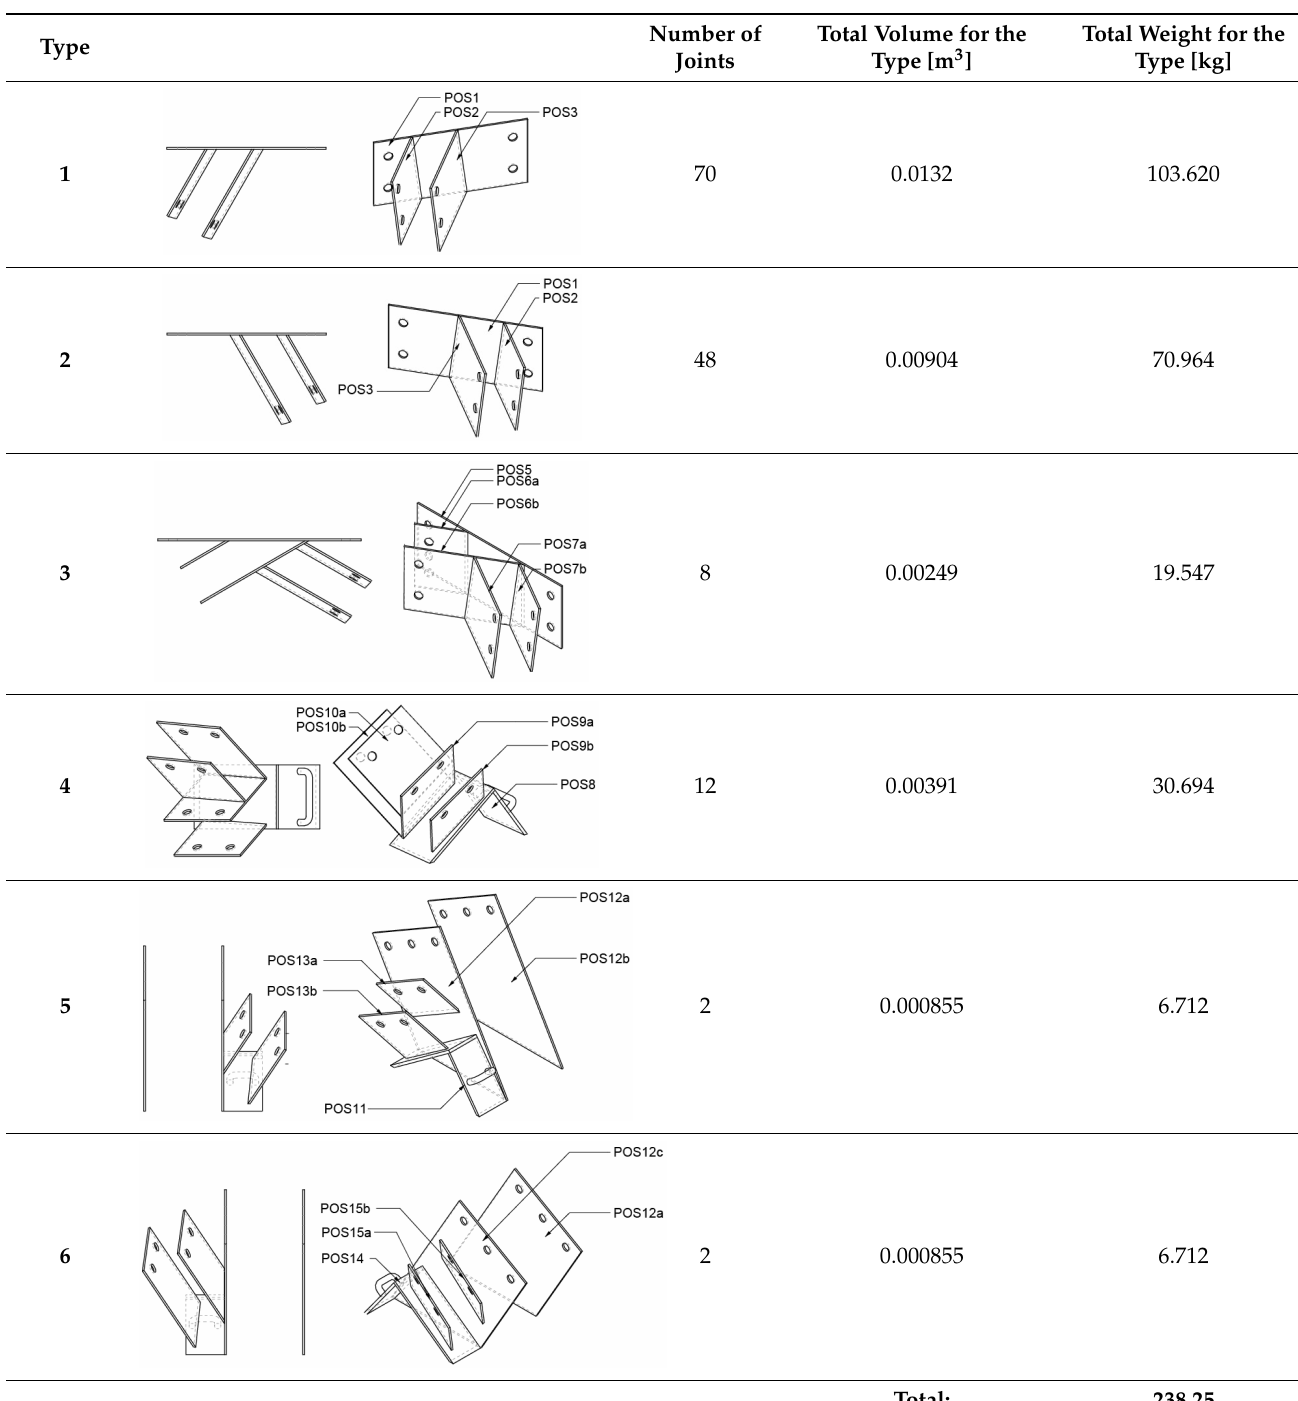
Table 2. Specification of steel